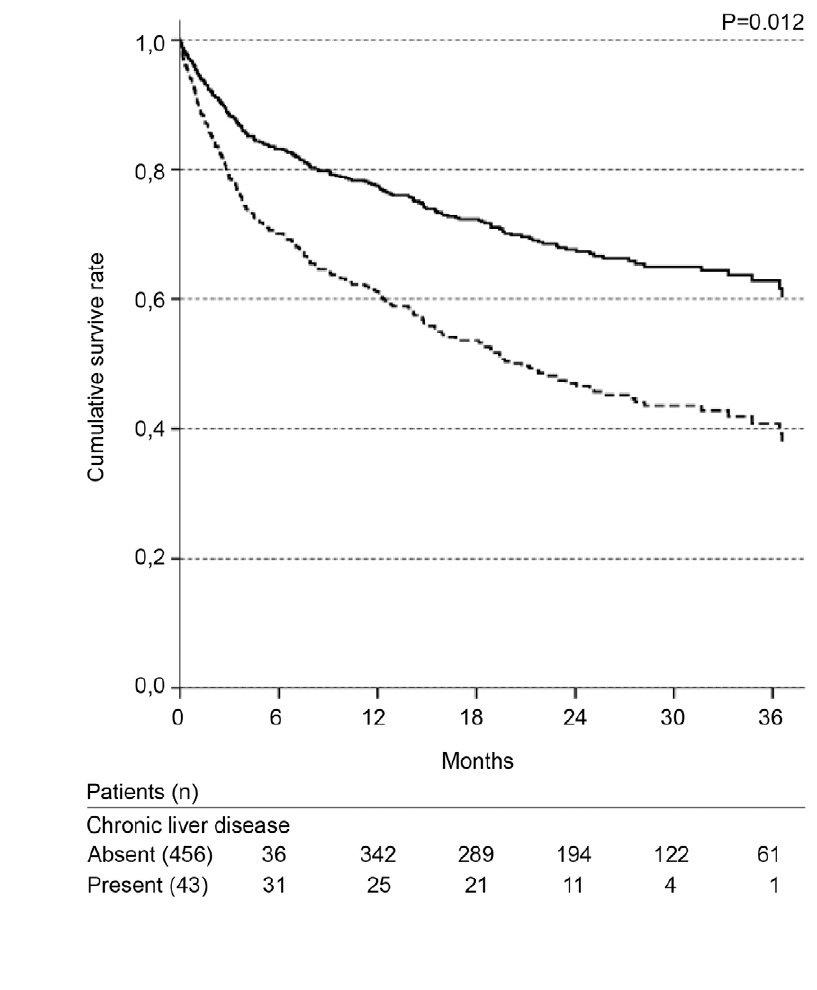
Figure 4. Cox survival curves according to chronic liver disease. Solid line: absence; dotted line: presence. Adjusted for: gender; age; presence of cancer, heart failure, and presumed chronic kidney disease; nephrotoxic and septic etiologies.